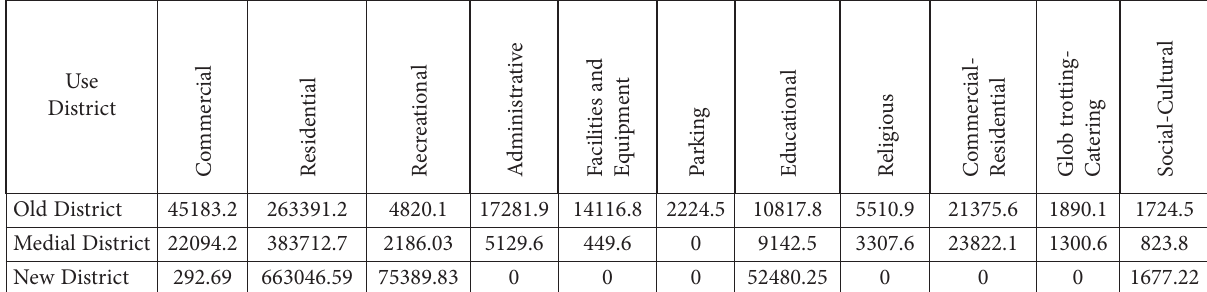
Table 2. Area of the uses in the three studied regions (source: